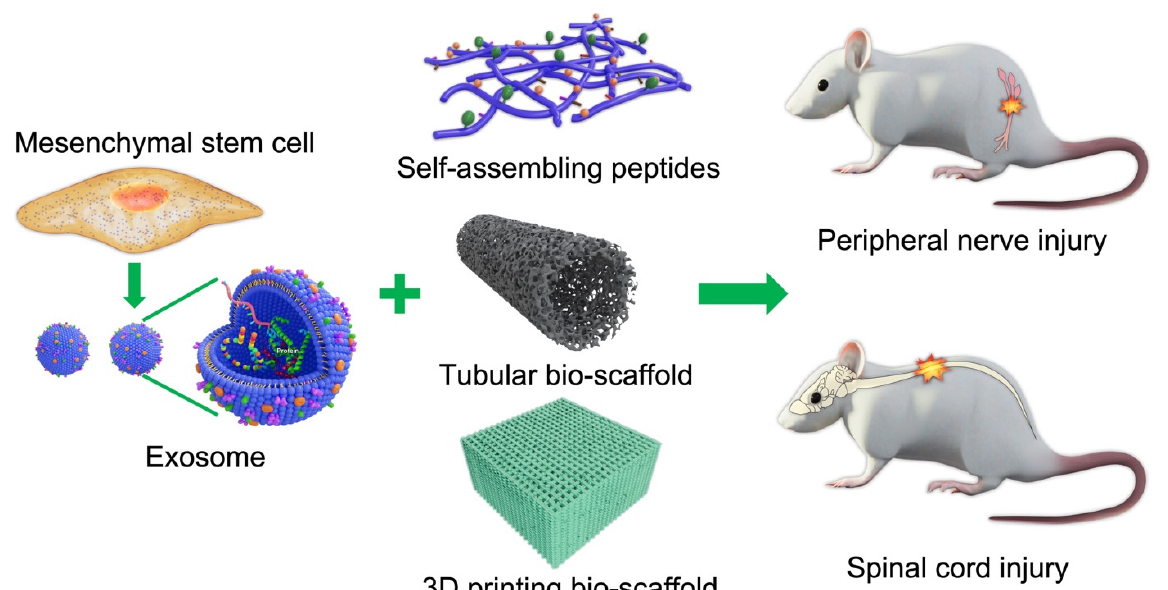
Figure 1. Schematic illustration of cell/exosome and bio-scaffold combinations for the treatment of central and peripheral nerve injury.